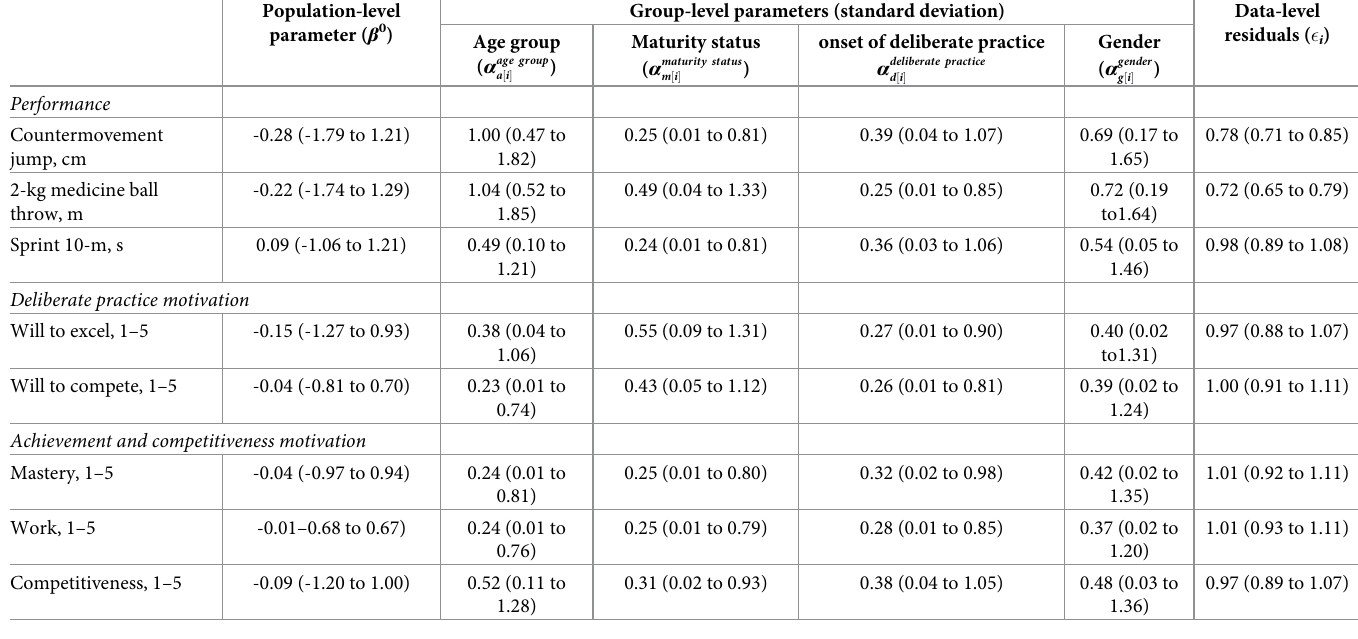
Table 2. Multilevel regression models estimates and 90% credible intervals of young Brazilian volleyball players performance and motivation adjusted by age group, maturity status, onset of deliberate practice and